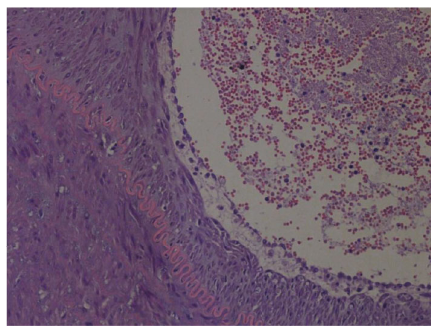
Figure 8: Pathological section of the femoral artery in the fi rst experimental animal.